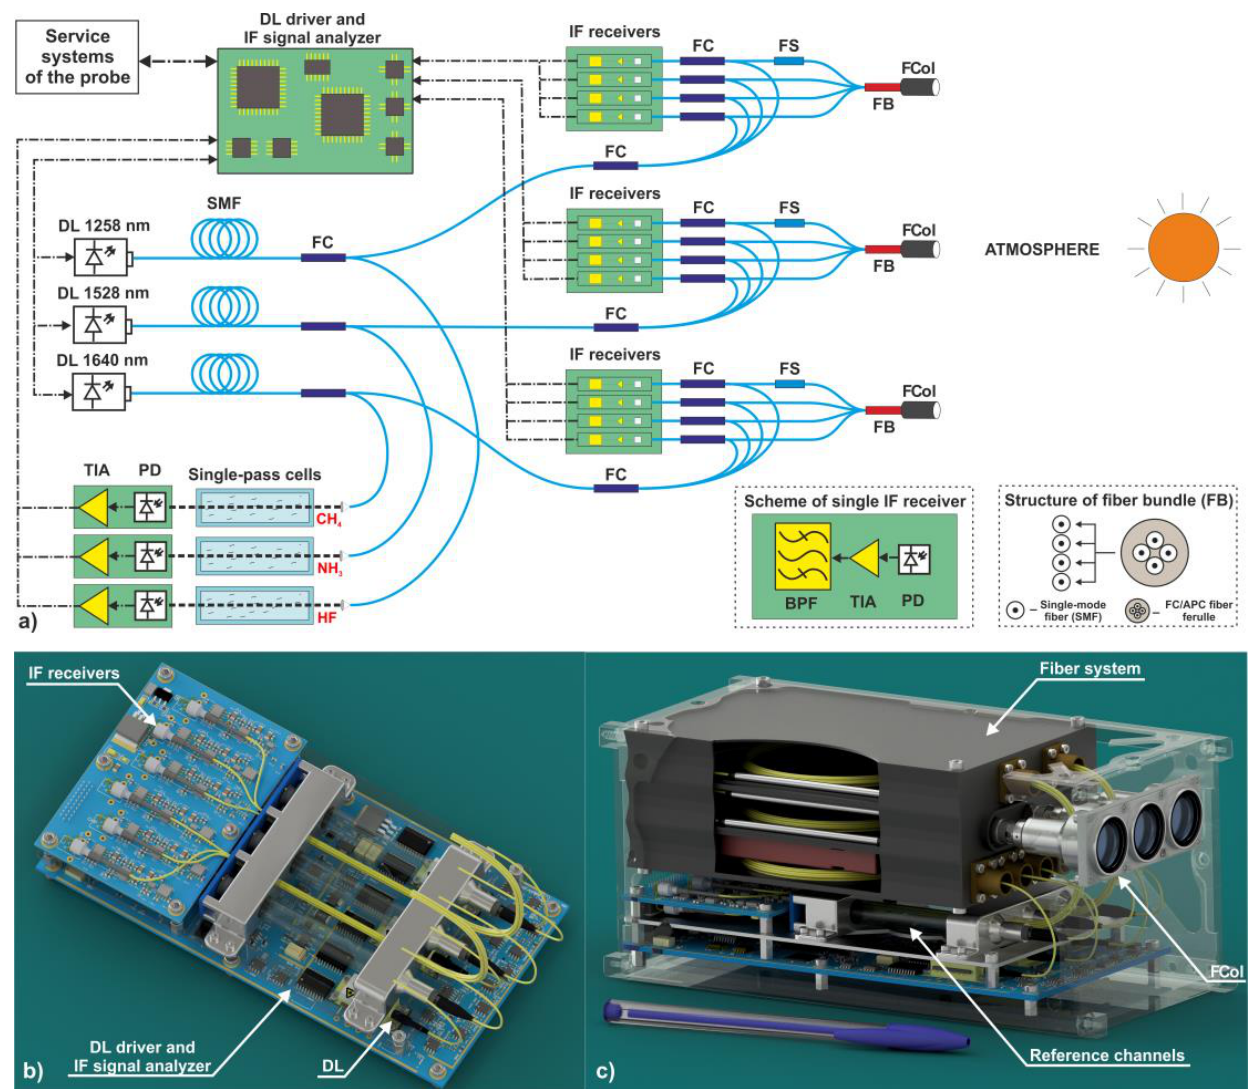
Figure 12. ( a ) The sketch of spaceborne MLHS schematic diagram. DL is a diode laser; SMF is a single-mode optical fiber; FC is a fiber coupler; FS is a fiber switch; FCol is a fiber collimator; FB is a fiber bundle; PD is a photodiode; TIA is a transimpedance amplifier; BPF is a bandpass filter. ( b , c ) The model of spaceborne MLHS in 2U CubeSat form-factor.